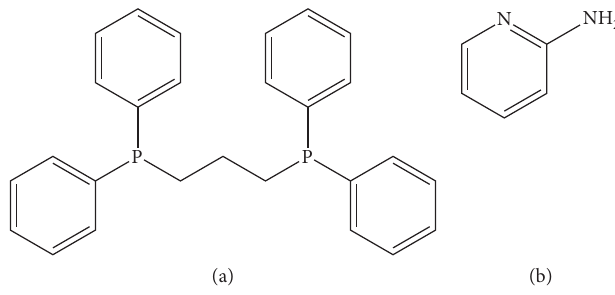
Figure 1: Structure of the ligands. (a) 1,3-Bis(diphenylphosphino)propane. (b)